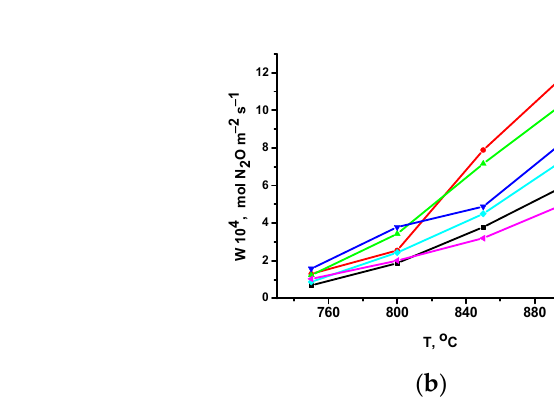
Figure 8. Temperature dependence of nitrous oxide decomposition degree ( a ) and nitrous oxide decomposition rate ( b ) for LaMn 1 − x Fe x O 3 perovskites.